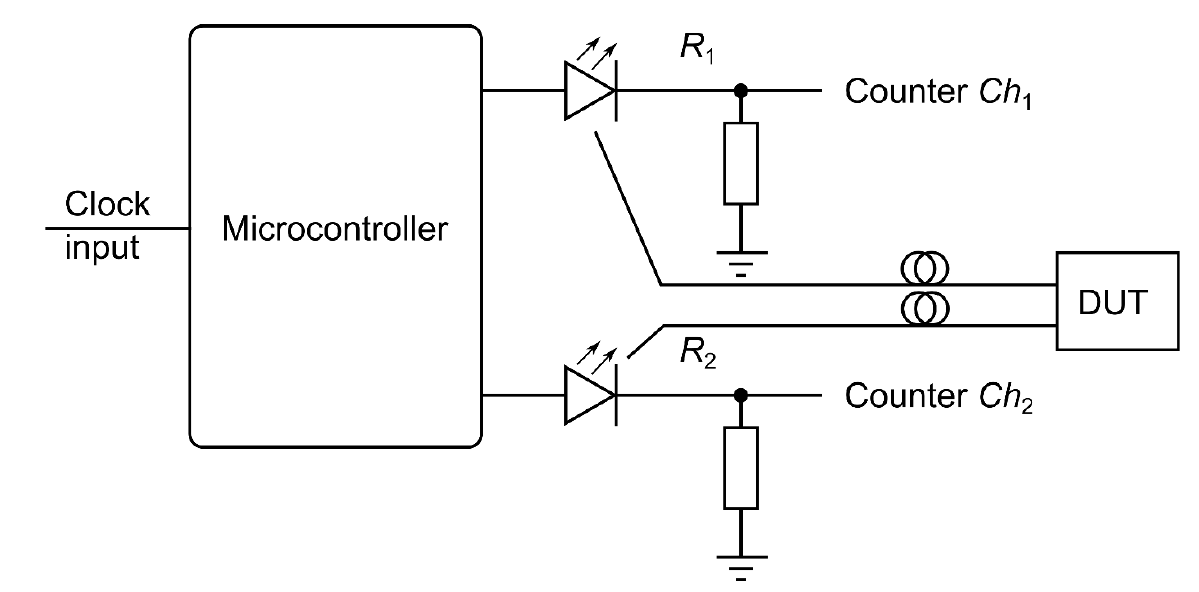
Figure 2. Block diagram of the measuring setup for calibration.